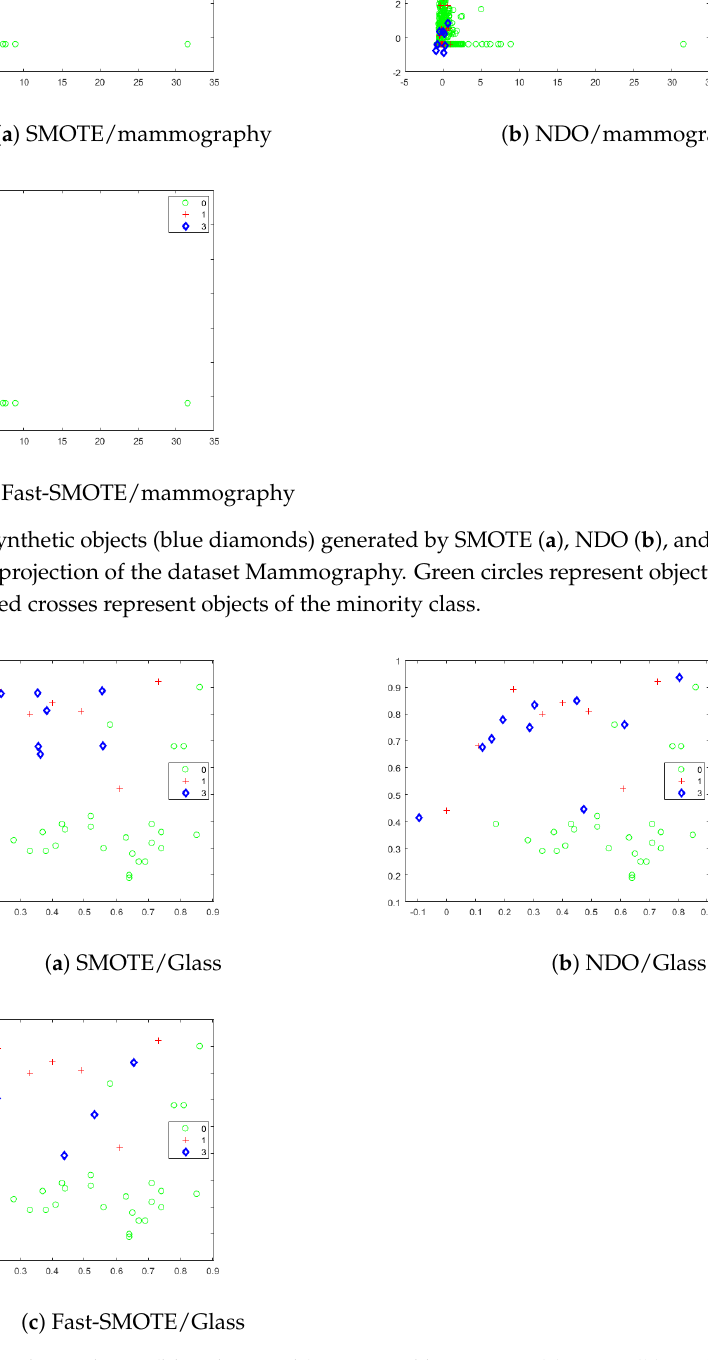
Figure 2. Synthetic objects (blue diamonds) generated by SMOTE ( a ), NDO ( b ), and Fast-SMOTE ( c ) over a 2-D projection of the dataset Glass. Green circles represent objects of the majority class, and red crosses represent objects of the minority